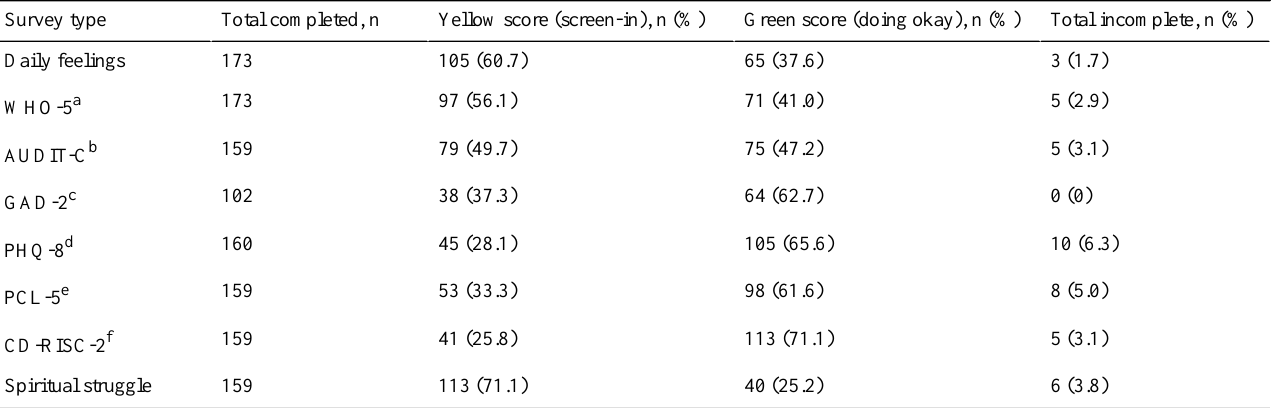
Table 1. Survey-specific completion at baseline and screen-in